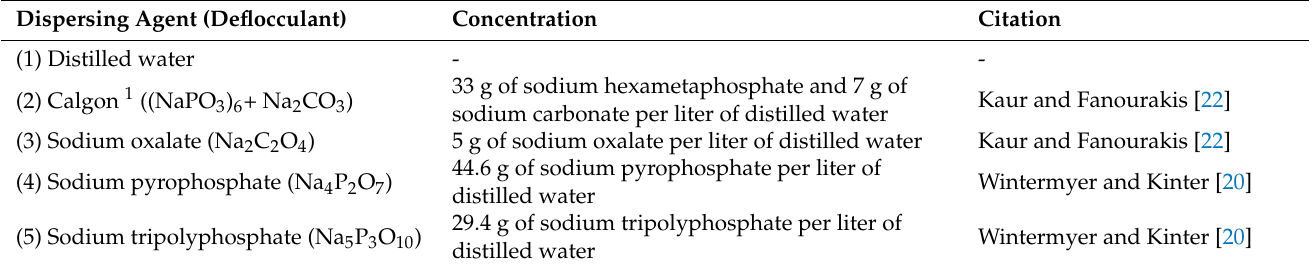
Table 1. Details and concentration of chemical dispersing agents used. Dispersing Agent (Deflocculant) Concentration